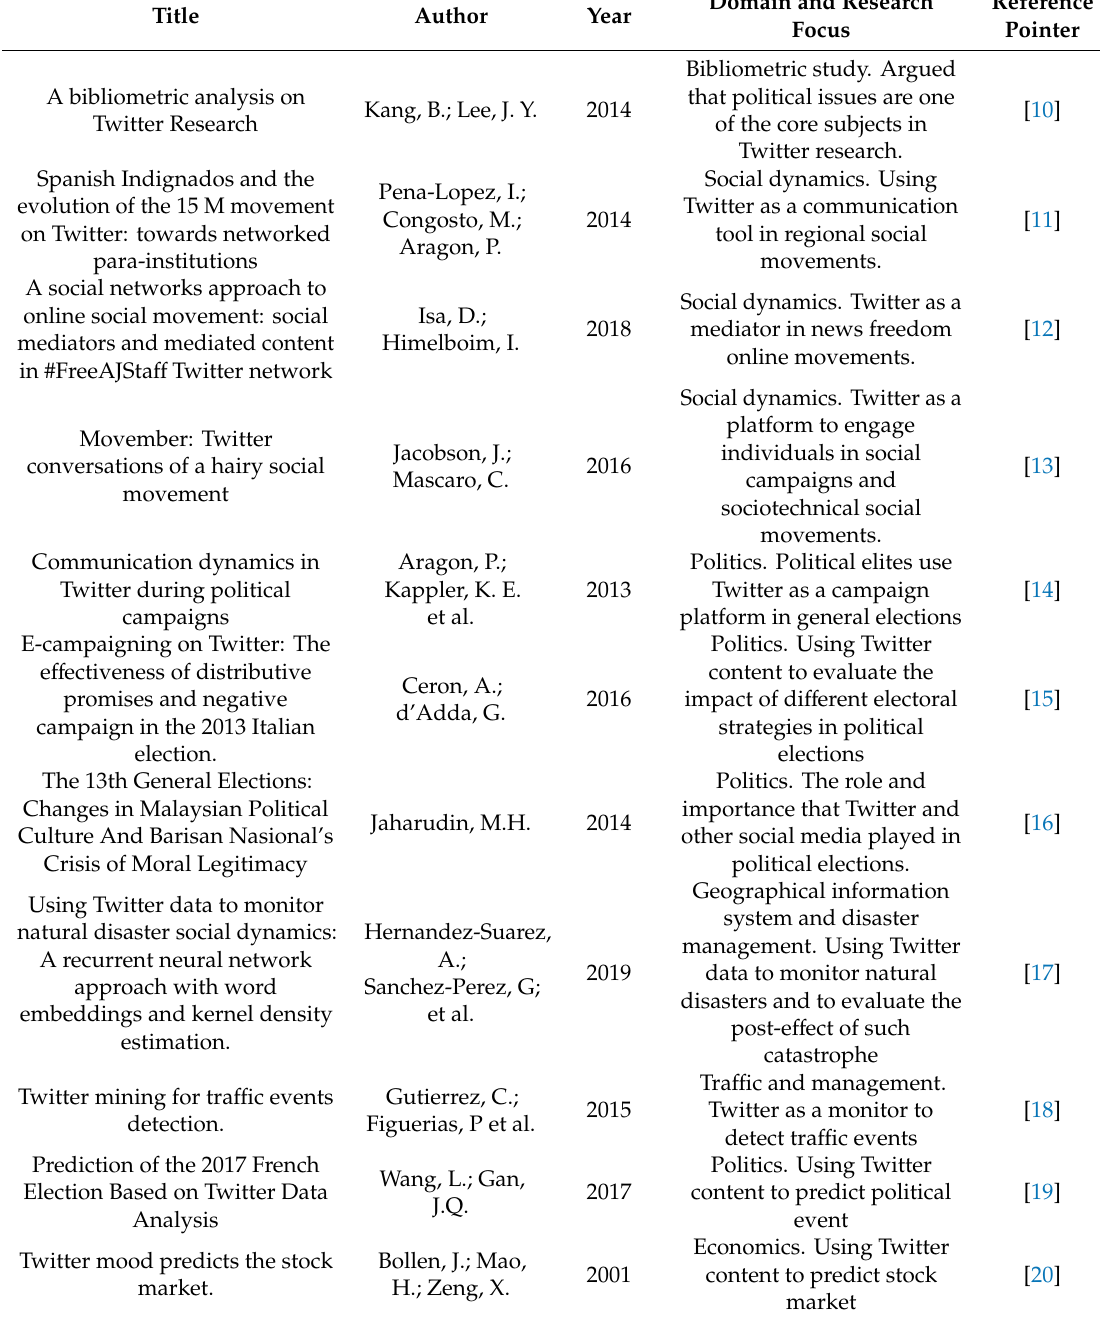
Table 1. Summary table of the reviewed scientific